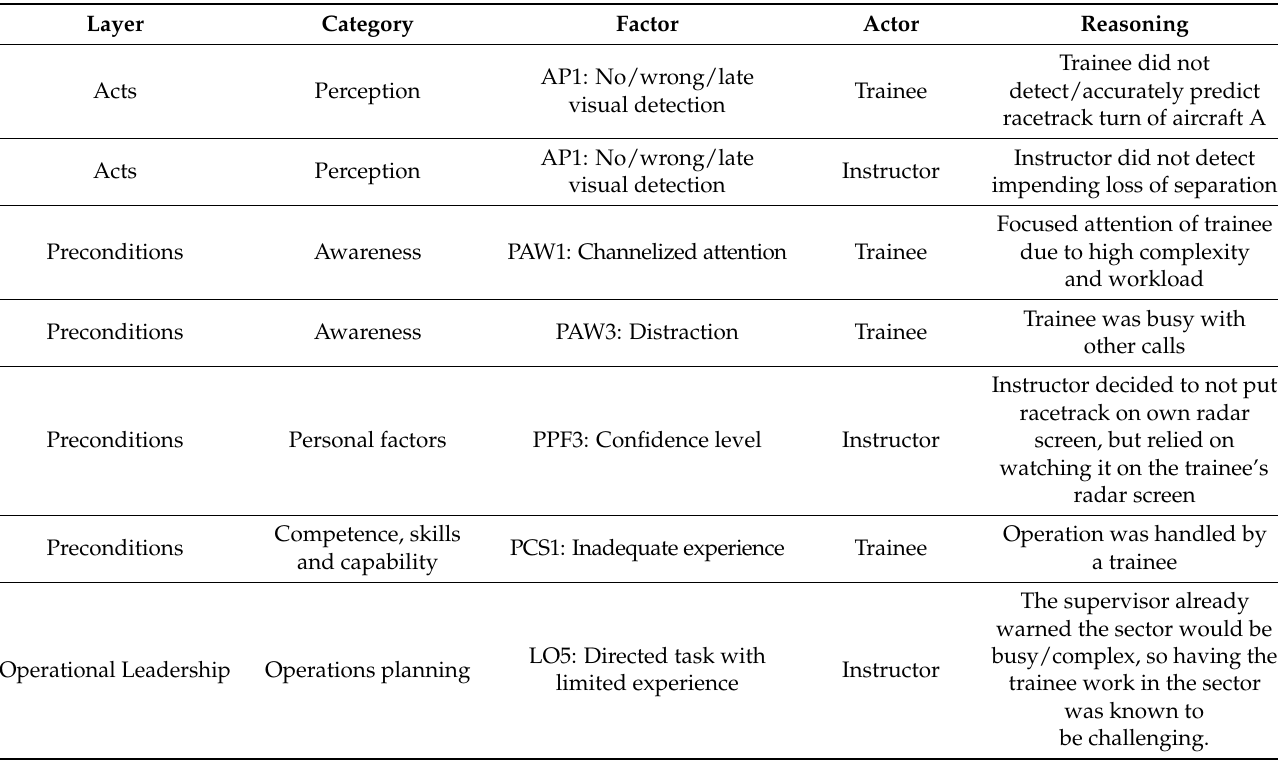
Table 2. Identified human factors in the example occurrence of Table